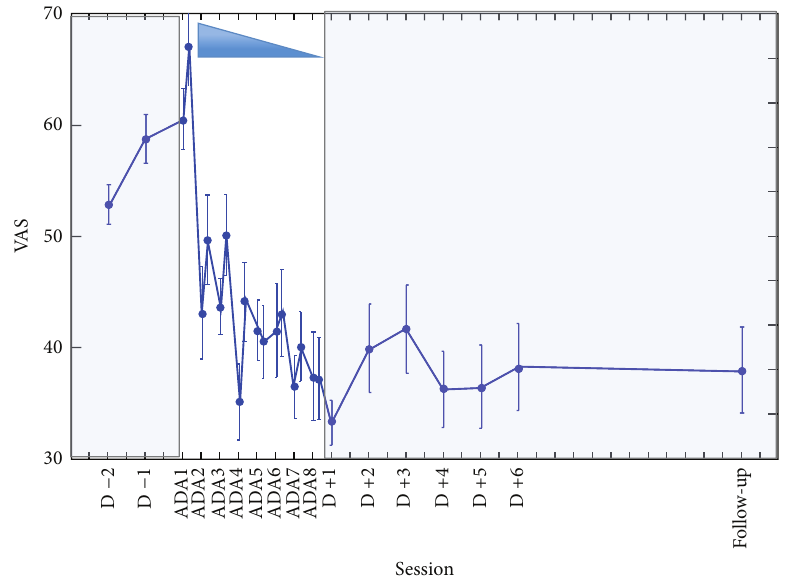
Figure 6: Evolution of mean pain ( ± SEM) for the 7 patients from 2 days before prism adaptation to follow-up consultation. In white background is the prism rehabilitation period. The shaded background indicates the pre- and postperiods of follow-up. Before the intervention, the apparent increase of average pain level was not confirmed by individual analyses. During the intervention period, a substantial decrease of pain is observed. Following the intervention and up to the follow-up consultation (D +15), remarkable stability of pain measures was